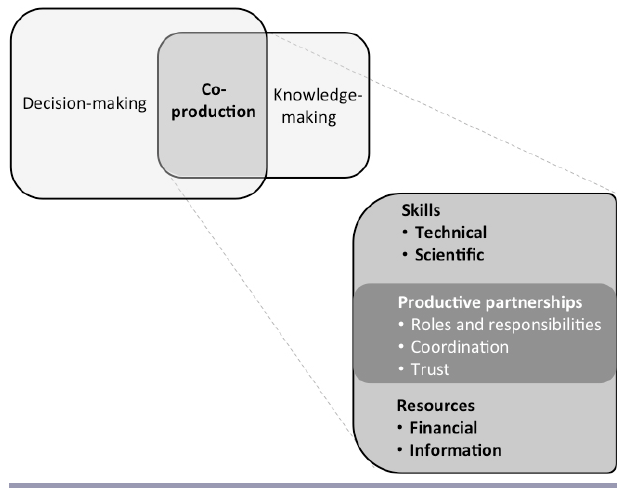
Fig. 1 . Schematic representation of the components of coproduction and coproductive capacity in the context of climate change adaptation in the health and water sectors in Cambodia, as identified through interviews with key